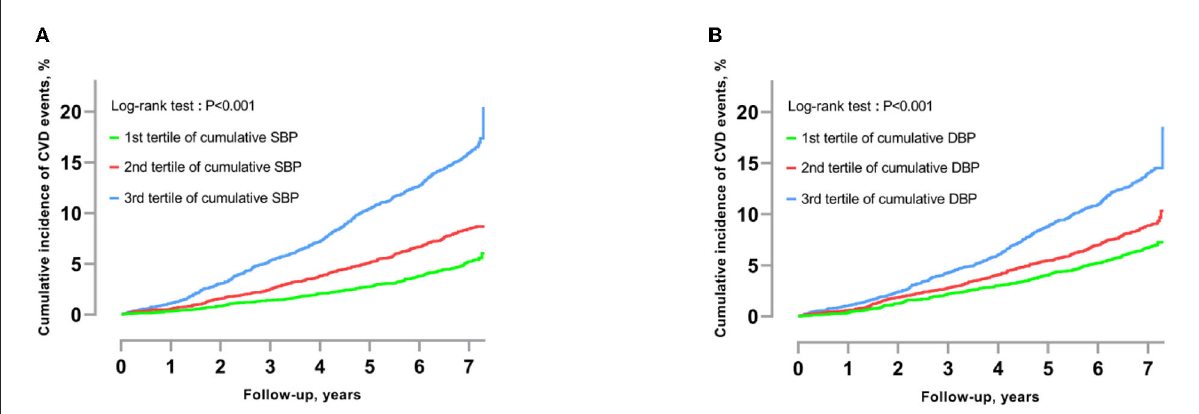
FIGURE2 (A) Cumulative incidence of CVD by tertile of cumulative systolic BP. (B) Cumulative incidence of CVD by tertile of cumulative diastolic BP. The cumulative incidence of CVD by tertile of cumulative BP was calculated using the Kaplan–Meier method. The log-rank test was used